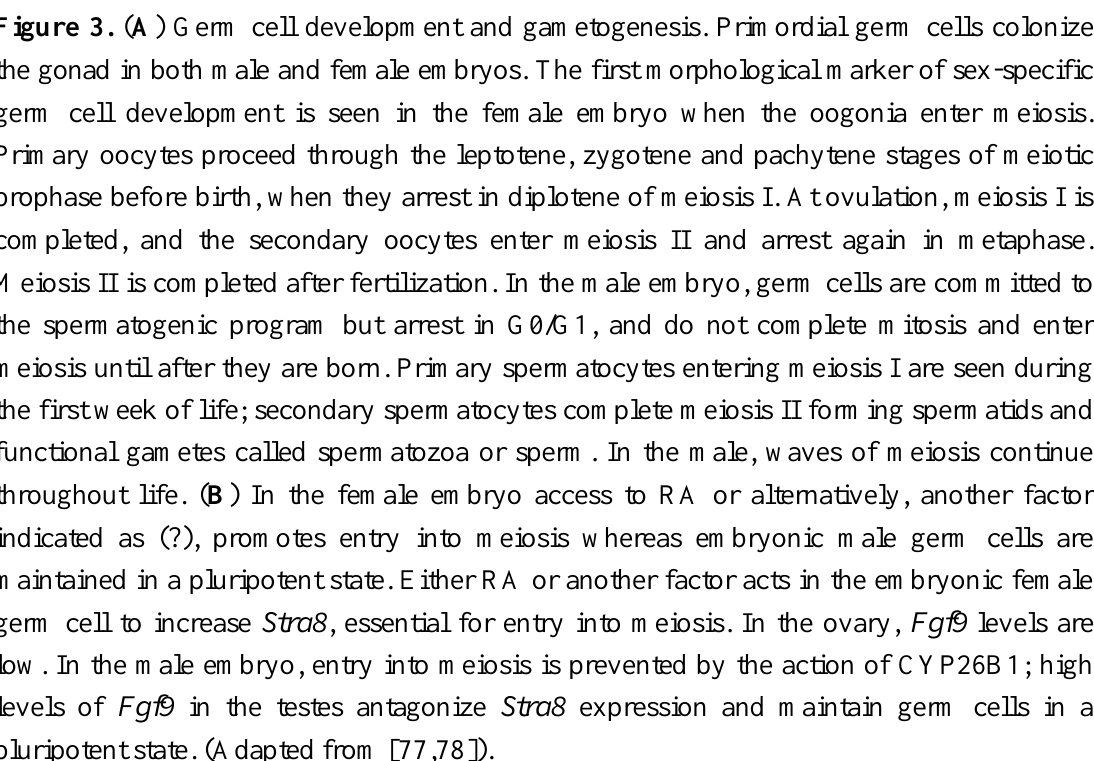
Figure 3. ( A ) Germ cell development and gametogenesis. Primordial germ cells